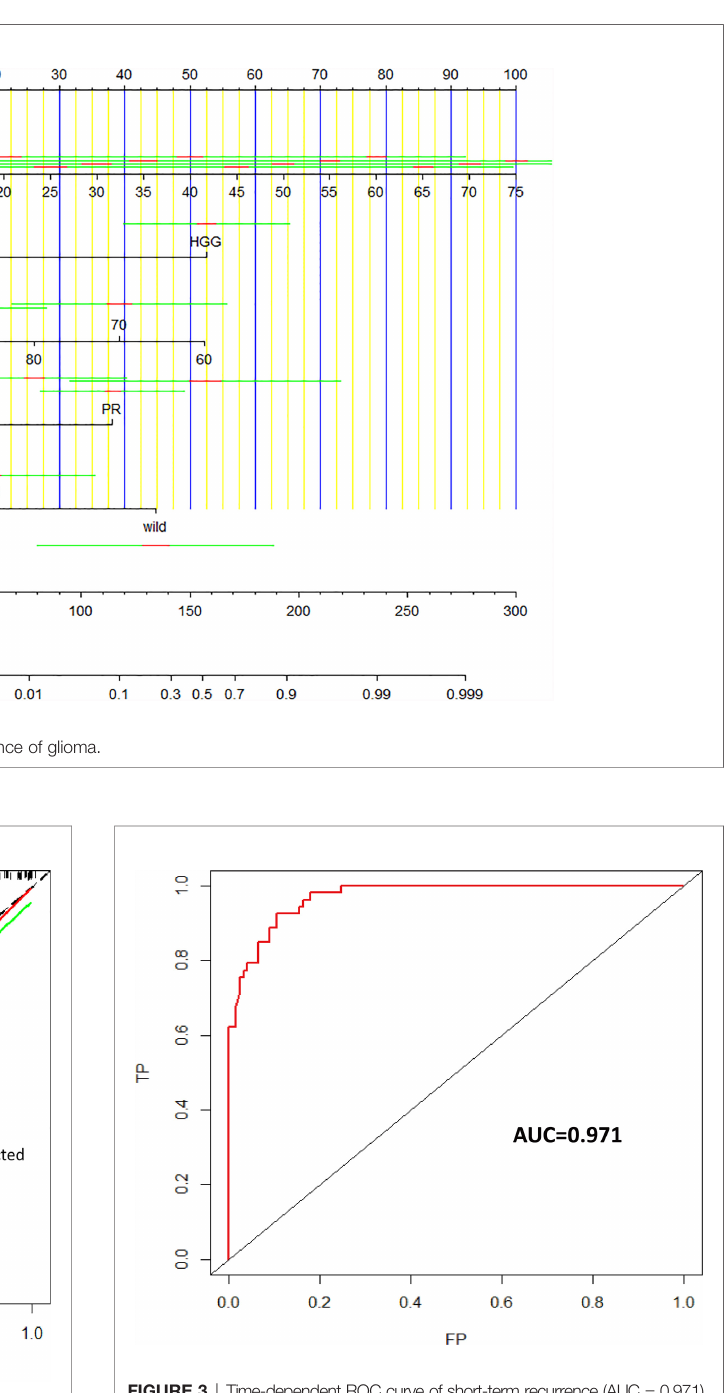
FIGURE 2 | Calibration curve for the risk of short-term